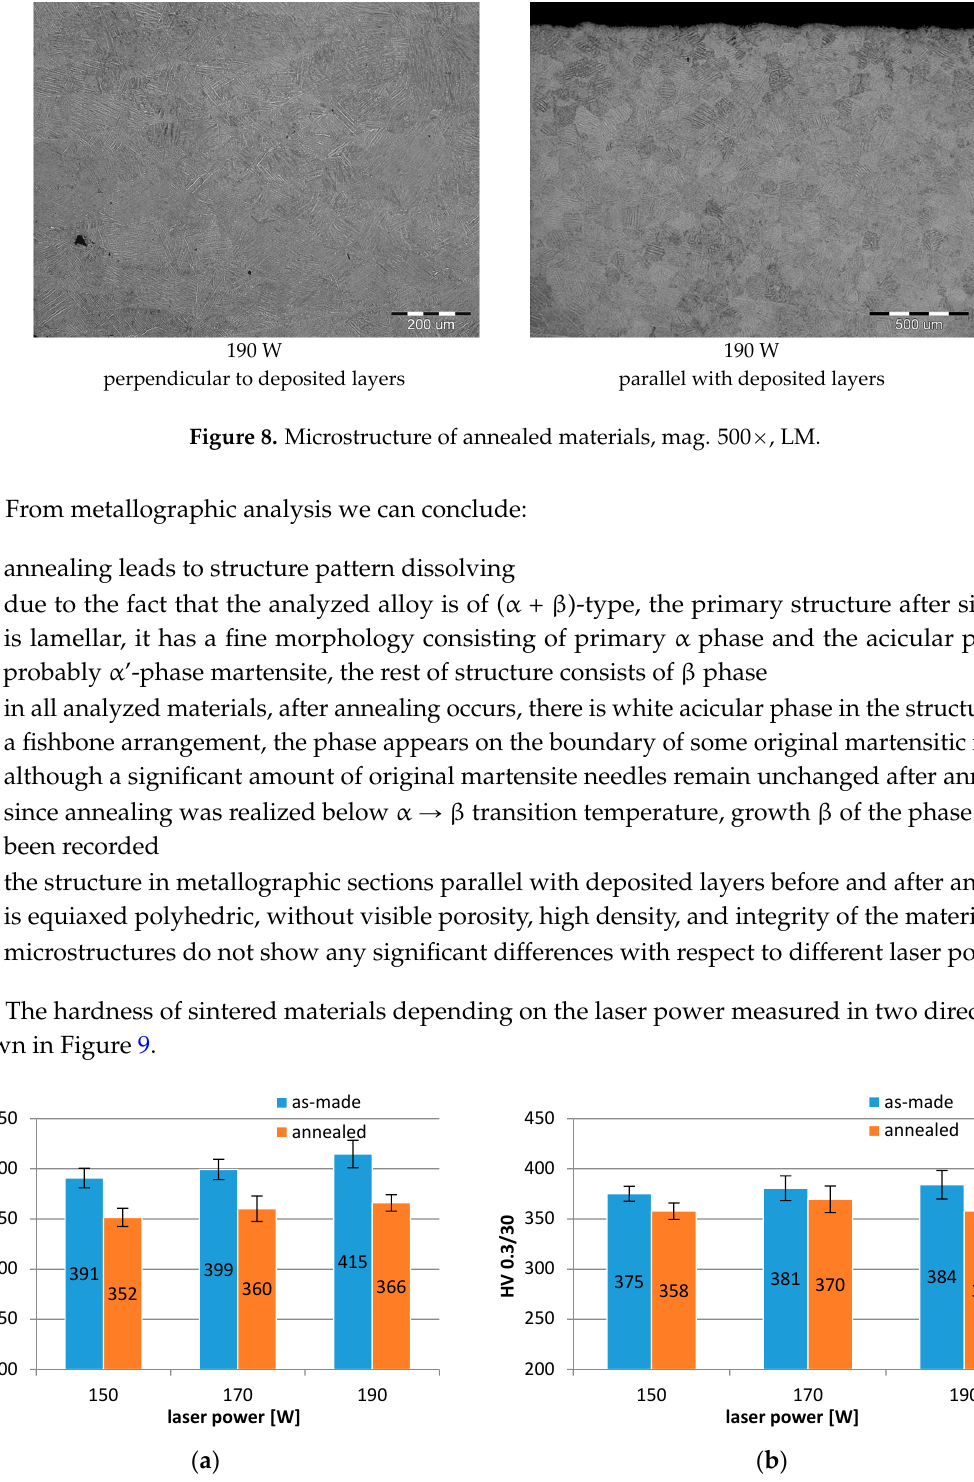
Figure 9. Hardness of materials depending on the laser power and the direction. ( a ) Perpendicular to deposited layers; ( b ) parallel with deposited layers.